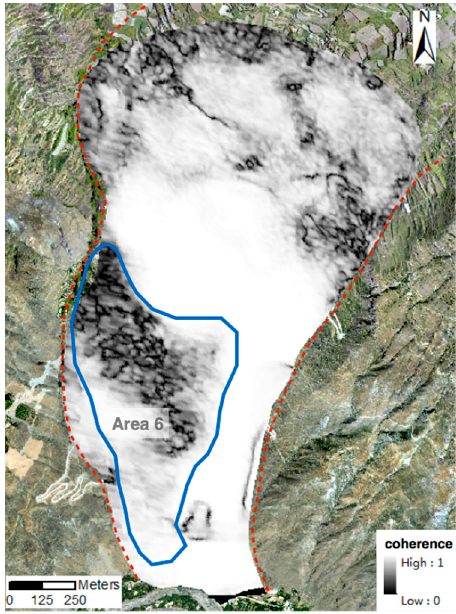
Figure 10. The interferometric coherence map for the pair of 17 February 2015–11 March 2015. The area with low coherence corresponds to Area 6, namely the most densely-vegetated region circled by blue lines.